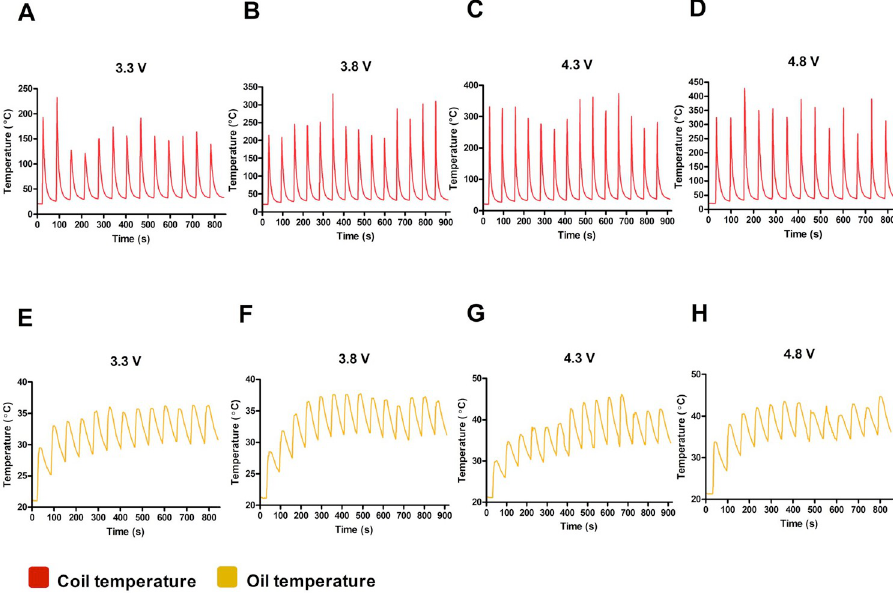
Fig 1. E-cigarette temperature profiles. Temperature profiles of (A–D) e-cigarette coil at 3.3, 3.8, 4.3, and 4.8 V, and (E–H) VEA oil in contact with the atomizer tube at 3.3, 3.8, 4.3 and 4.8 V. Measurements were taken every 1 s over a 1 min cycle; the battery was activated to heat the coil for 4 s, then the pen was allowed to rest for the remaining